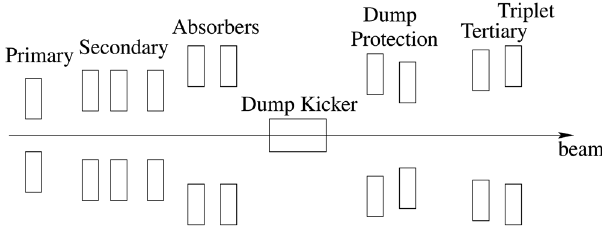
FIG. 2. Simplified sketch of the gap opening arrangement of collimator classes normalized by beam size, adapted from [12].